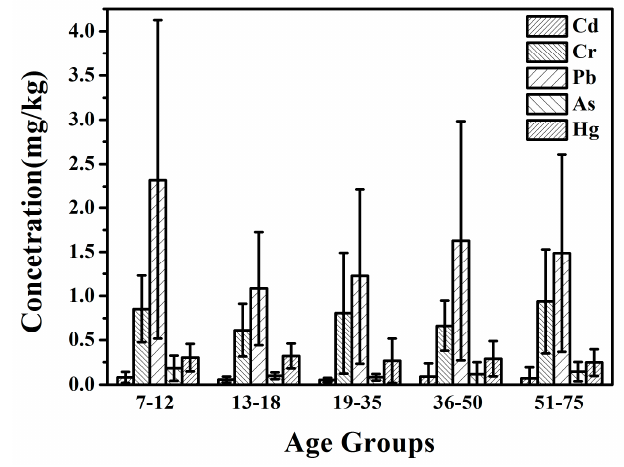
Figure 2. Concentrations of hair heavy metals of different age groups.